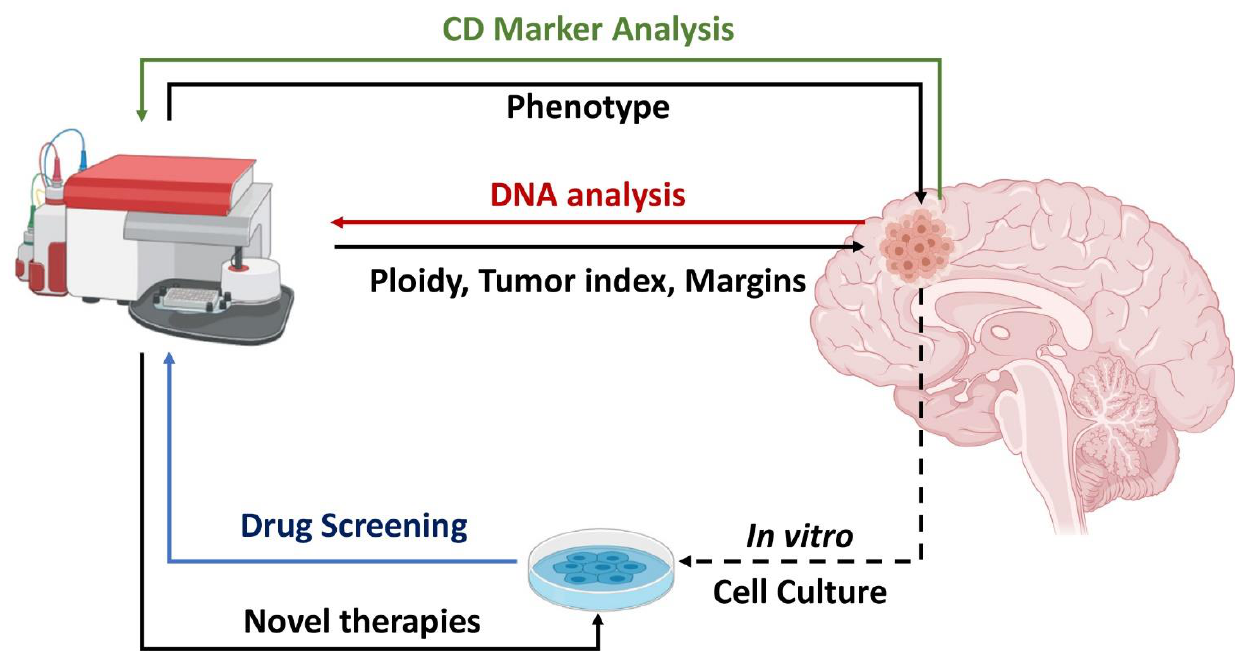
Figure 1. Utility of Flow Cytometry in central nervous system malignancy (CNSM) analysis. CNSM cells can be directly analyzed intraoperatively or post-surgical for DNA content (red arrow), offering information on ploidy, tumor index, and tumor margins. CNSM analysis for Cluster of Differentiation (CD) markers (green arrow) can provide information on tumor phenotype and possibly on the clinical outcome. Analysis of in vitro CNSM cultures (blue arrow) may offer insights on drug efficacy. Created with BioRender.com.